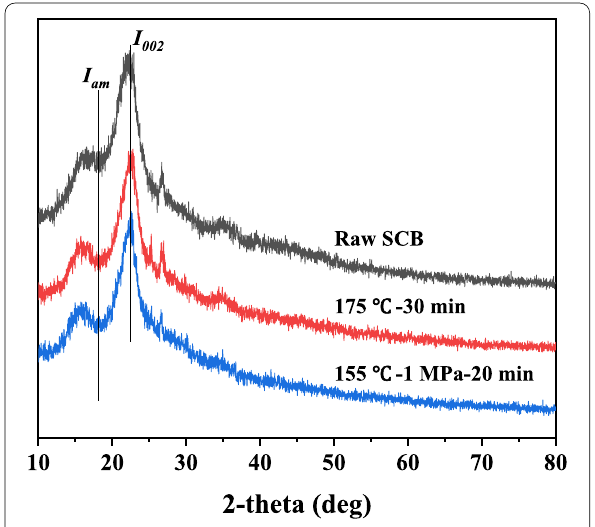
Table 4 BET surface area, total pore volume and average pore size of SCB and solids pretreated by different processes